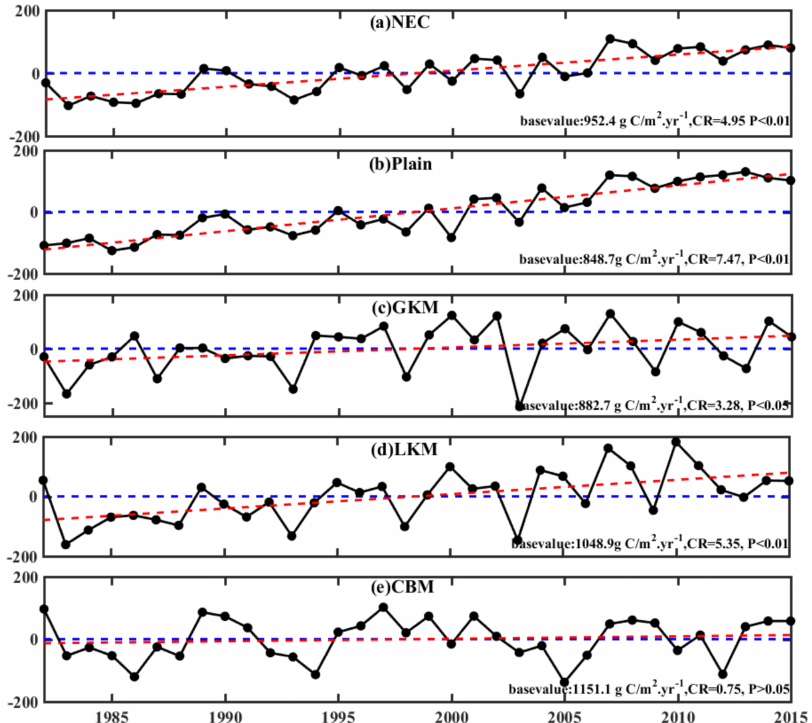
Figure 3. Trend of regional GPP GS anomalies (true value of GPP GS minus multi-average GPP GS ) from 1982 to 2015 in five zones (the Greater Khingan Mountain (GKM), Lesser Khingan Mountain (LKM), the ChangBai Mountain (CBM), and Plain and the whole NEC) of the NEC (Here, the base value (the blue line) is the multi-year average GPP GS from 1982 to 2015; CR refers to the change ratio of GPP GS (g C/m 2 . yr − 2 ), and P refers to the significance testing. The red line is a trend line calculated by the MK